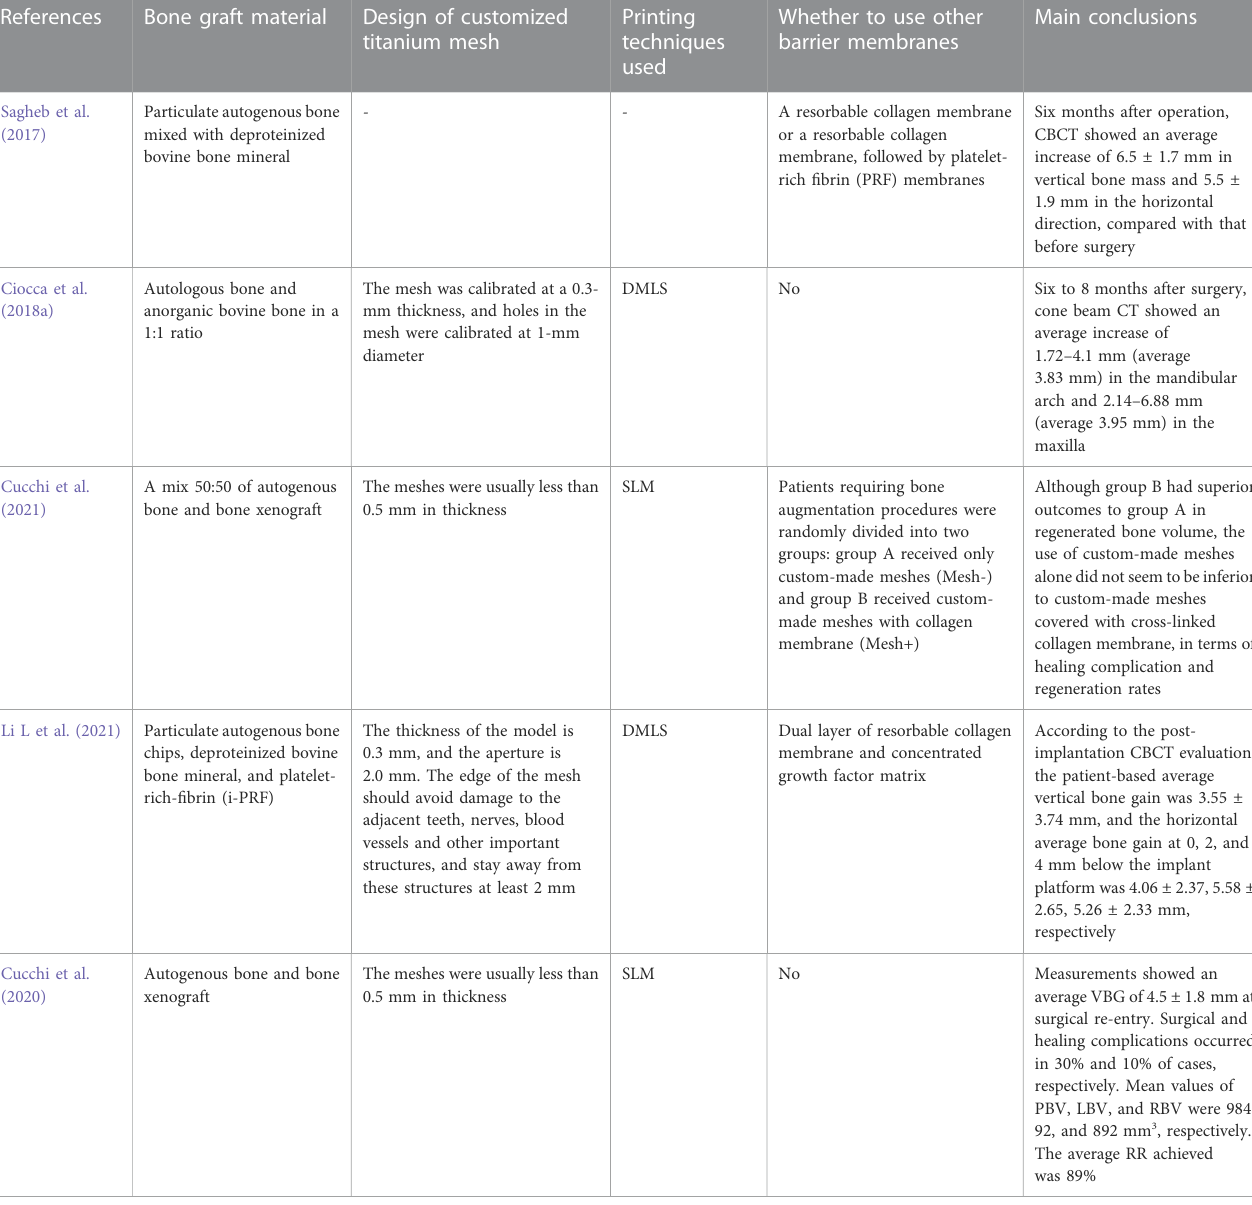
TABLE 2 Different studies used 3D printing titanium mesh to obtain the effect of bone